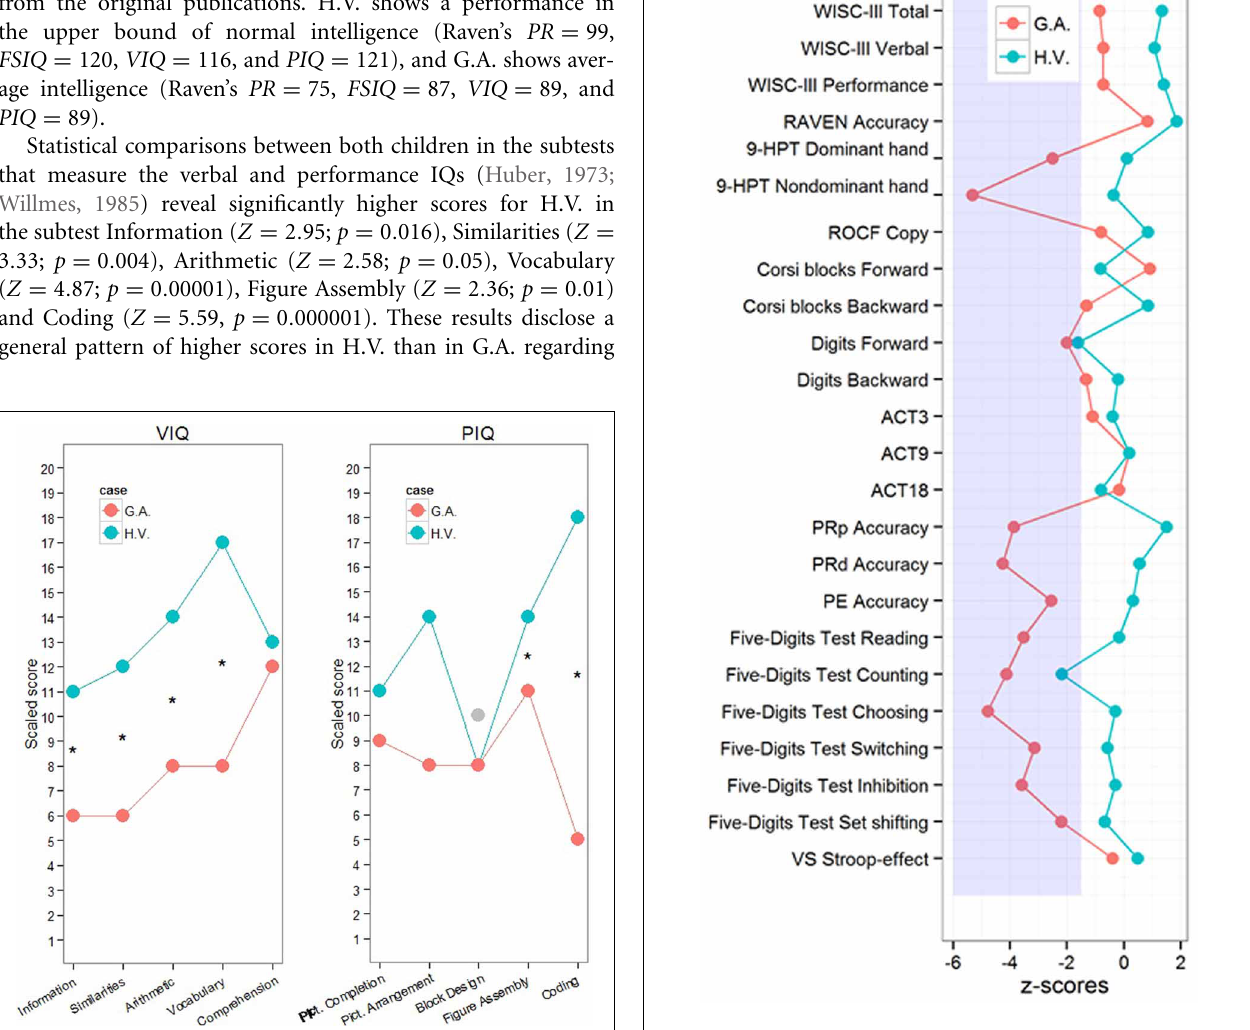
FIGURE 2 | H.V. and G. A. performances in WISC-III. ∗ Marked statistical significance at the level p < 0 . 001. Note: as H.V.’s standardized Block Design score was below the mean in the first assessment, this subtest was repeated two years later (gray dot). The new standardized score in Block Design was equal to 10.